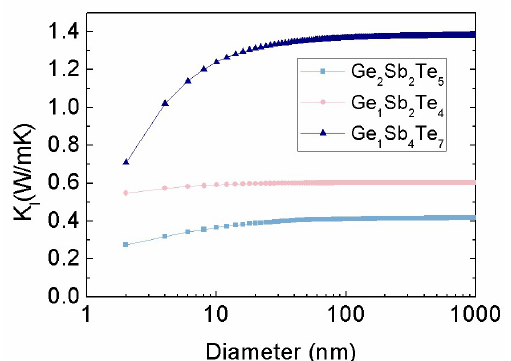
Figure 6. Calculated lattice thermal conductivities for h -GST nanowires at room temperature as a function of the diameter of nanowires.